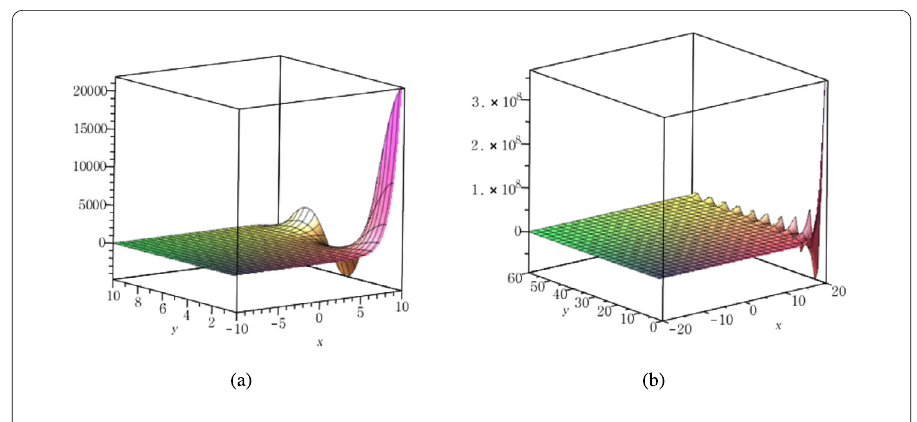
Figure 1 Illustration of the remainder term of D exp( p ) according to the range of x (= S p ) and y (= | V p | ) using Maple 20 ‘Plot3D’ function: ( a ) output of Plot3D of exp( x )sin( y ) Plot3D of exp( x )sin( y )